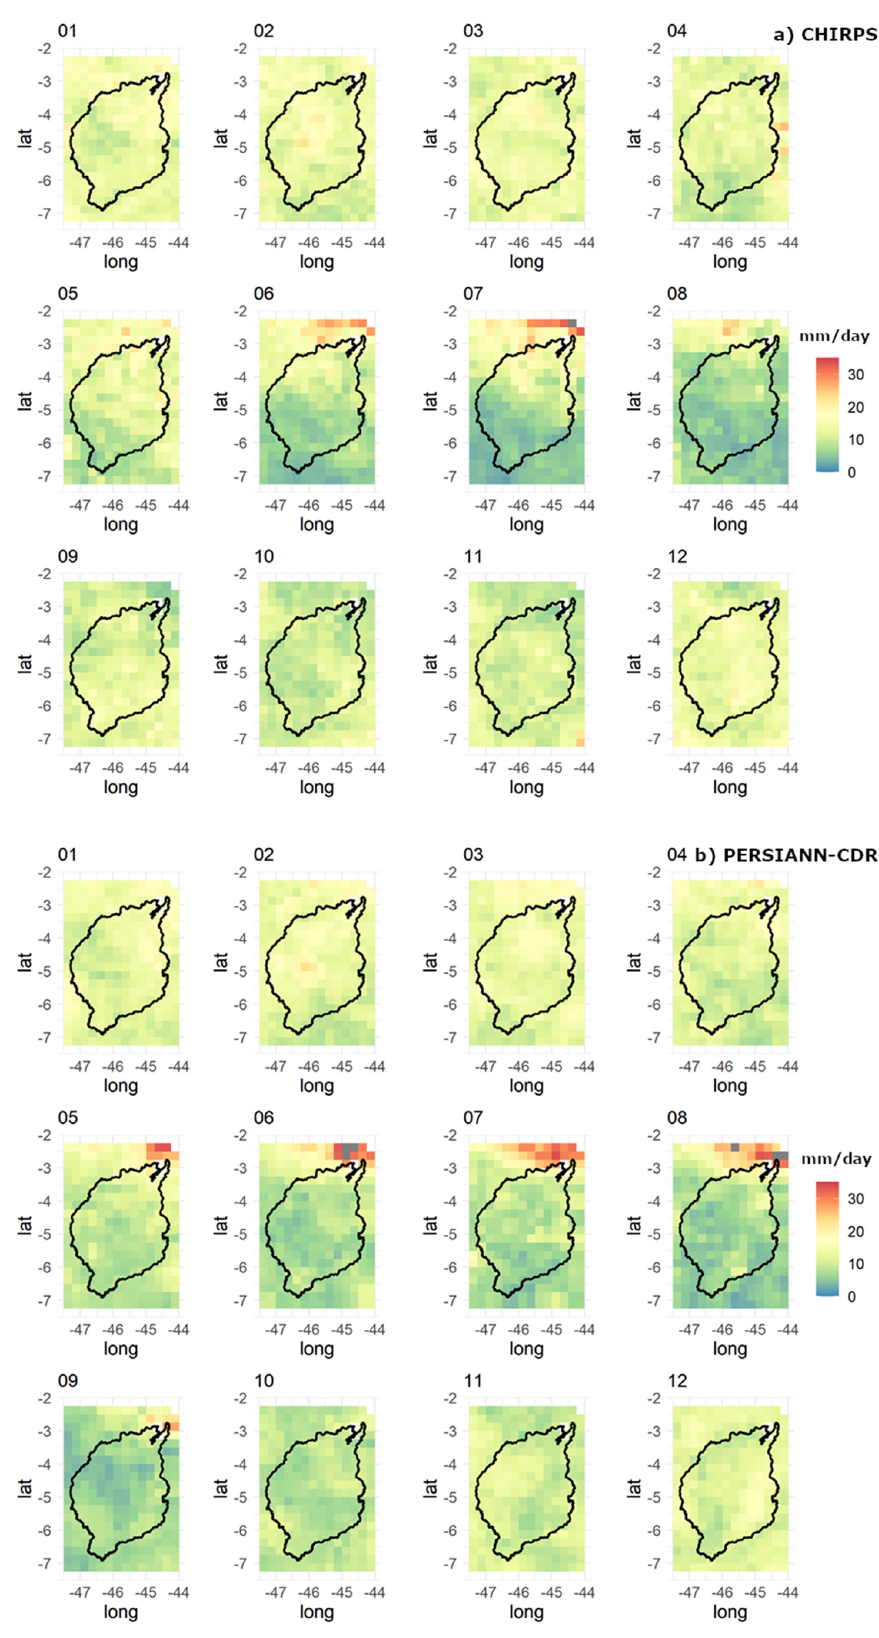
Figure 12. RMSE (mm/day) monthly rx1day (gridBR × CHIRPS ( a ) and gridBR × PERSIANN-CDR ( b )) from January (01) to December (12) 1983 to 2013. Values above 35 mm/day are colored by gray pixels.